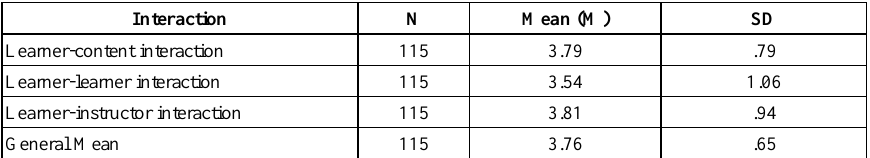
Table 1. Mean scores of participants’ perceptions on types of interaction